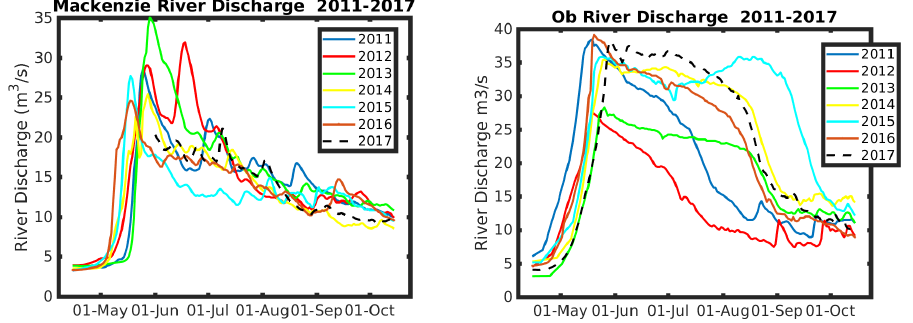
Figure 14. Daily river discharge from 2011 to 2017 from Arctic Great Rivers project: Mackenzie River ( left ); and Ob River ( right